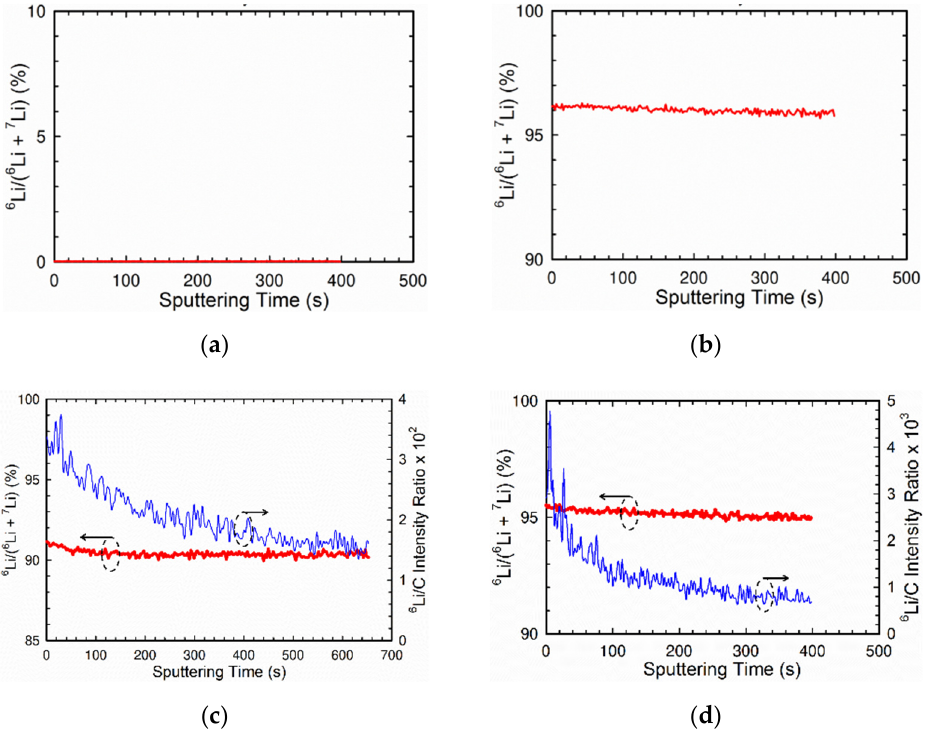
Figure 1. 6 Li composition and 6 Li to carbon (C) intensity ratio as a function of sputtering time for delithiated graphite anodes after different numbers of SEI formation cycles: ( a ) 7 Li-enriched control; ( b ) 6 Li-enriched control. ( c ) 7 Li-enriched SEI exchanged with 6 Li-enriched electrolyte, one formation cycle; ( d ) 7 Li-enriched SEI exchanged with 6 Li-enriched electrolyte, 25 formation cycles.